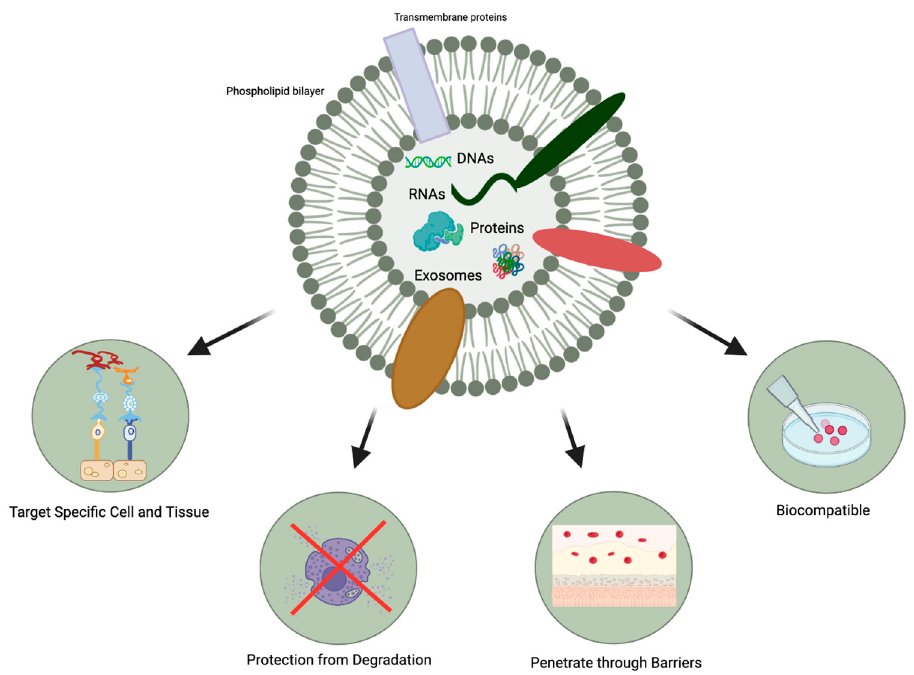
Figure 3. Favorable characteristics of MSC-exosomes.